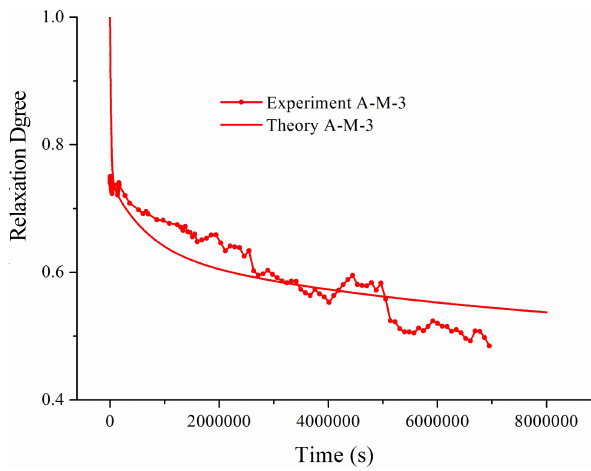
Figure 12: Comparison of preload relaxation for A-M-3